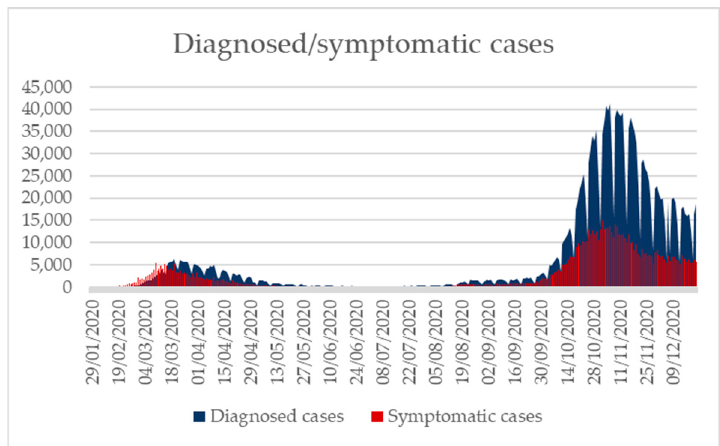
Figure 2. Diagnosed and asymptomatic cases, 29 January 2020–22 December 2020 (modified from [40]).